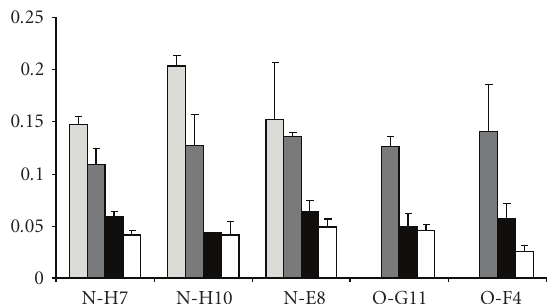
Figure 4: Cell surface ELISA. The selected purified Fabs were added to monolayers of Saos-2 cells (light gray bars), U2-OS cells (dark gray bars), and human fibroblasts (black bars). The bound Fabs were detected using rabbit anti-HA and HRP-conjugated anti- rabbit antibodies. Human serum albumin (white bars) was used as negative control. The absorbances were measured at 405 nm.